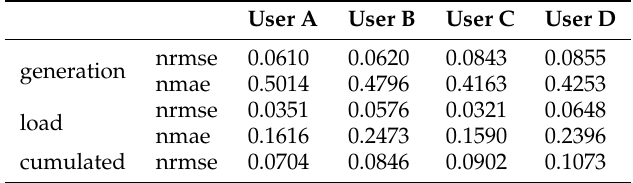
Table 5. Error metrics on input profiles.